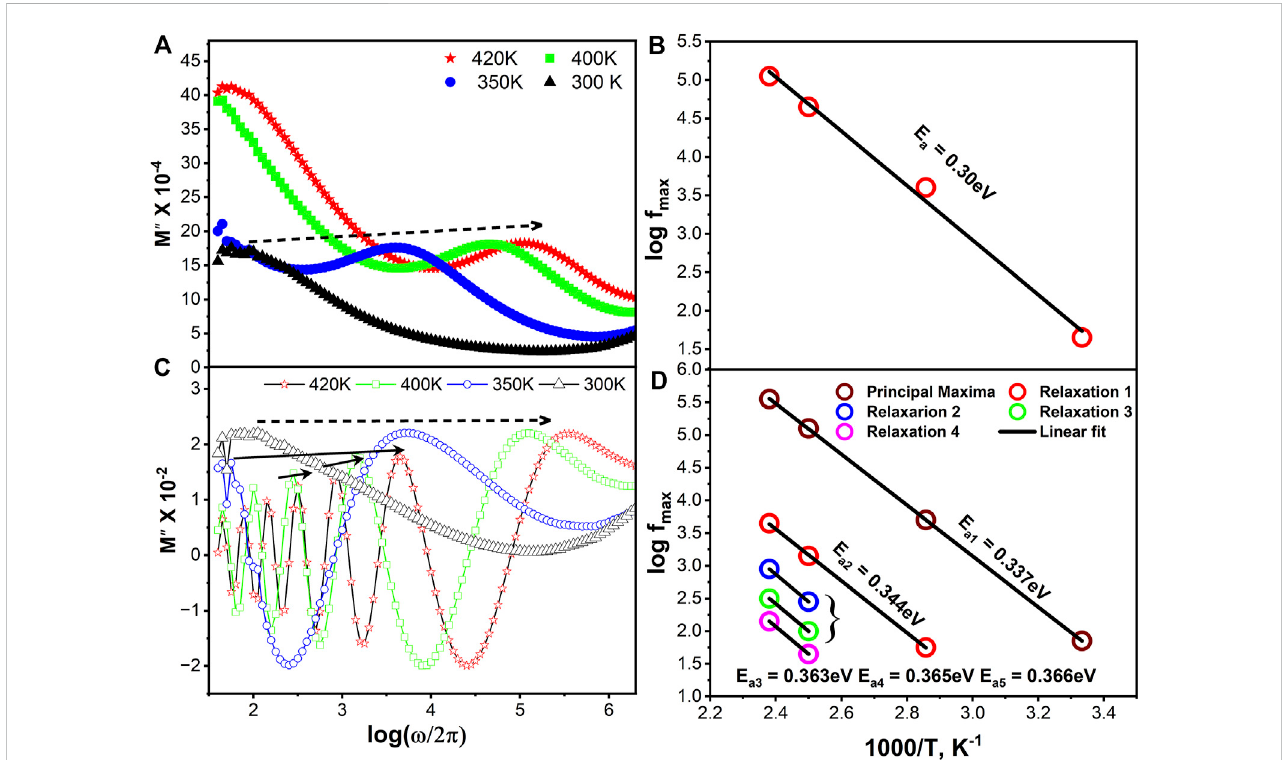
FIGURE 4 The frequency dispersion of imaginary part of modulus at discrete temperatures for pristine (A) (shown by solid symbols) and irradiated (C) (shown by hollow symbols) K 2 Bi 4 Ti 4 WO 18 . The activation energy pro fi le for pristine (B) and irradiated (D) KBTW shows activation energies corresponding to different